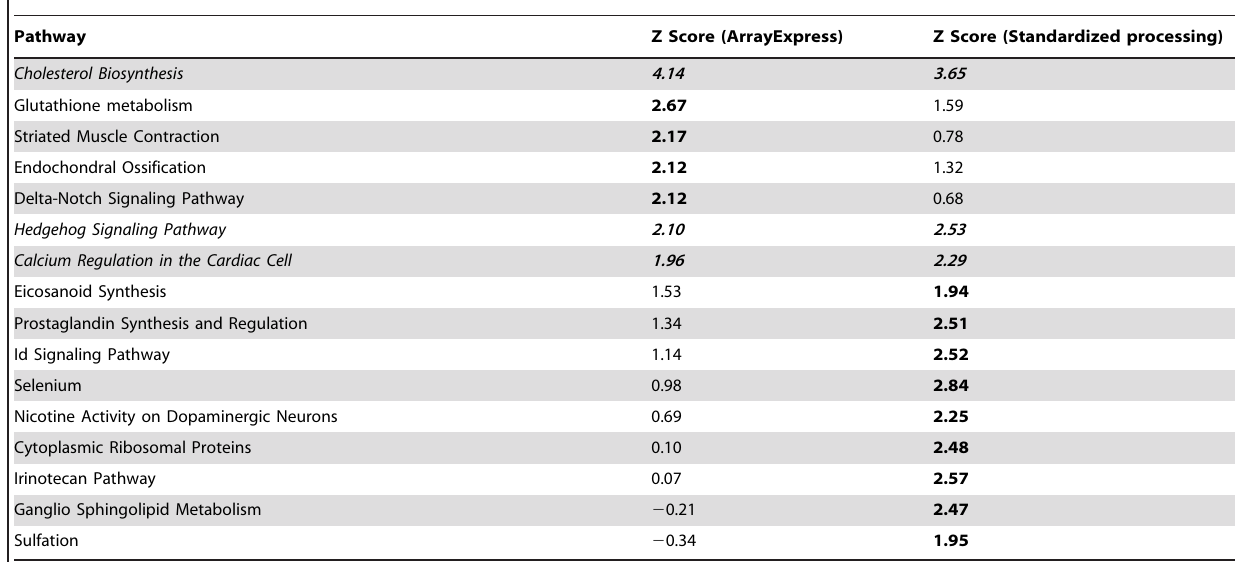
Table 2. PathVisio results of significant pathways found in the dataset by Varambally et al. comparing processed data provided by ArrayExpress with the reprocessed